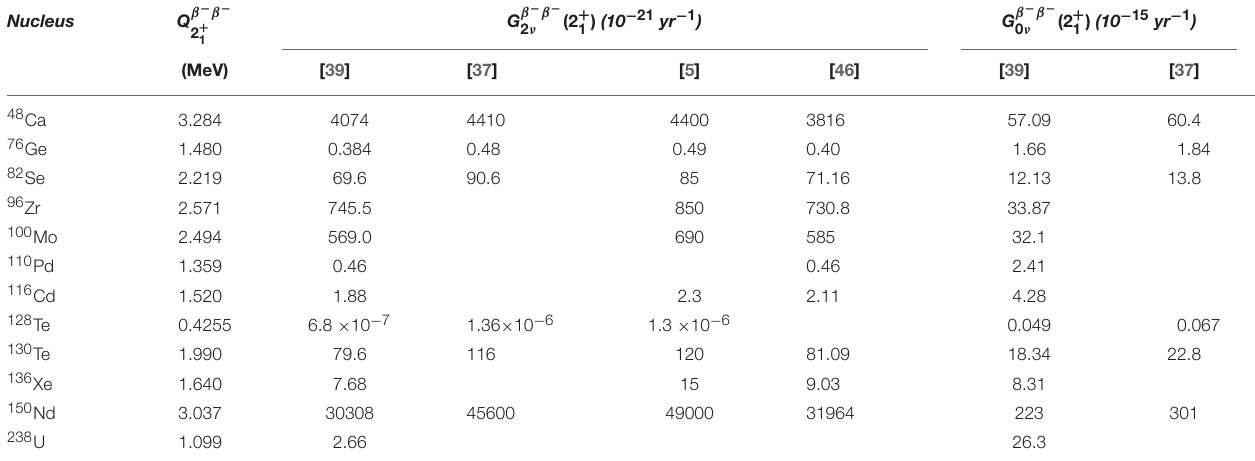
TABLE 4 | PSF for β − β − decays to final excited 2 + 1 states.